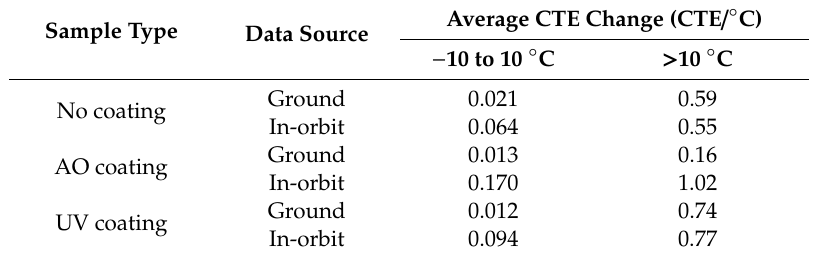
Table 4. Comparison of the average change in CTE with temperature for ground and in-orbit